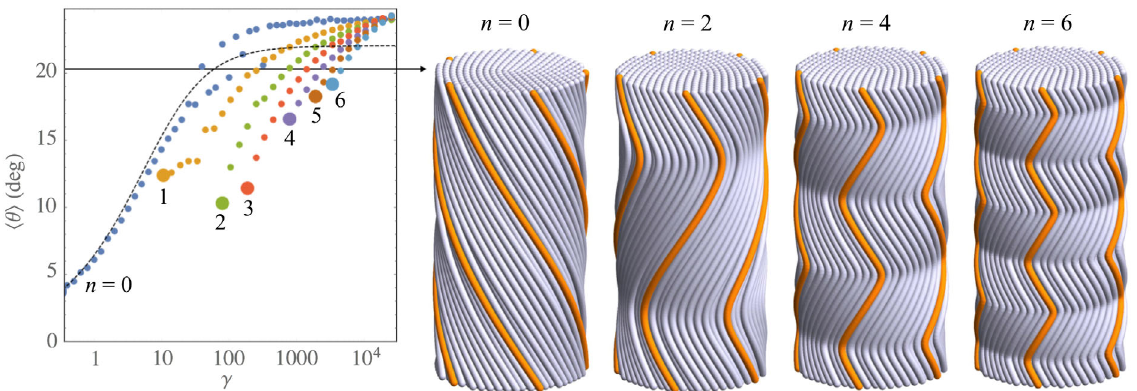
FIG. 4. Minimal energy results for the discrete model of bundles containing a single centered fivefold disclination, for various numbers of torsional wrinkles n . The mean twist angle h θ i is the mean angle of the filaments with respect to the z axis. Dashed black line shows Eq. (20) for the n ¼ 0 bundles, with γ c ¼ 0 , θ 0 ¼ 22 . 1 °, and ζ ¼ 32 = 3 , consistent with continuum elastic theory [30]. Renderings are shown of twisted bundles for four values of n at h θ i ≈ 20 °. Select outer filaments are highlighted orange for viewing